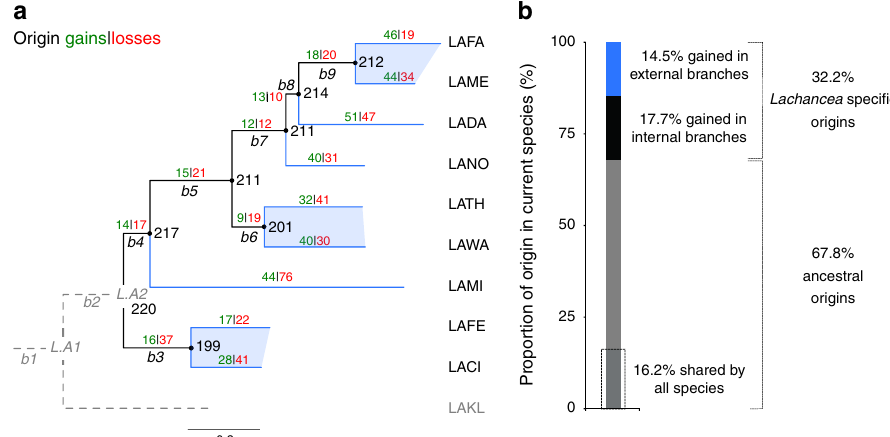
Fig. 3 Evolution of the repertoire of active replication origins in the genus Lachancea . a The phylogeny of the ten Lachancea species is taken from ref. 31 . Abbreviations of the species names: LAFA: L . fantastica , LAME: L . meyersii , LADA: L . dasiensis , LANO: L . nothofagi , LATH: L . thermotolerans , LAWA: L . waltii , LAMI: L . mirantina , LAFE: L . fermentati , LACI: L . cidri and LAKL: L . kluyveri . LAKL was used as the outgroup species; therefore evolutionary events that occurred on both the LAKL and the b2 branches (dotted lines) could not be retraced. Internal branches, labeled b3 to b9 , and terminal branches are drawn in black and blue, respectively. The number of origin gains (in green) and losses (in red) were estimated for each branch of the tree under a birth-death evolutionary model. The inferred number of active replication origins in the ancestral genomes is indicated next to the corresponding node of the tree. b The histogram indicates the proportion of active origins that were vertically inherited from the L . A2 ancestor (in gray), gained on internal branches of the tree (in black) and gained on terminal branches (in blue). The proportion of ancestral origins retained in all nine genomes is indicated by the open